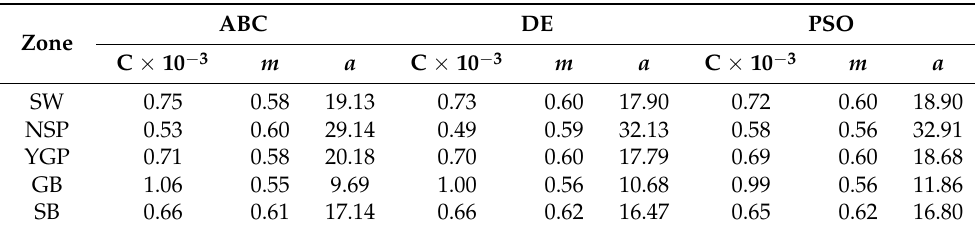
Table 2. The average value of calibrated parameters in the HG model in the southwestern regions based on the ABC, DE and PSO optimization